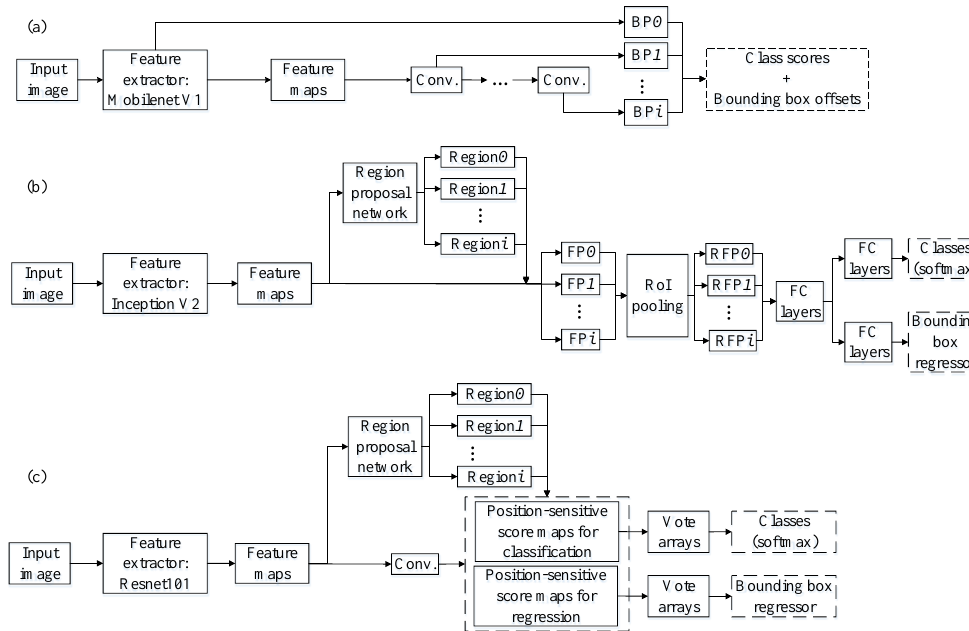
Figure 2. Schematic illustration of ( a ) single shot detector, ( b ) faster region-based convolutional neural network, and ( c ) region-based fully connected network. Conv. is convolutional layer, BP i is the i th box predictor, Region i is the i th region proposal, FP i is the i th feature patch, RFP i is the i th resized feature patch, and FC layers are fully-connected layers.